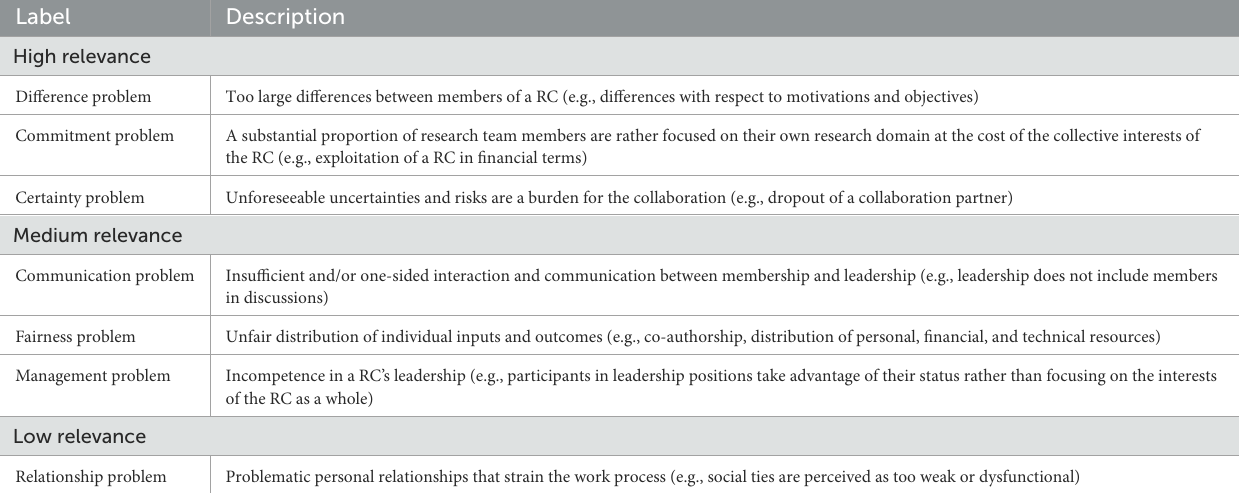
TABLE 1 Collaboration problems and their perceived relevance (Meißner et al., 2022). Label